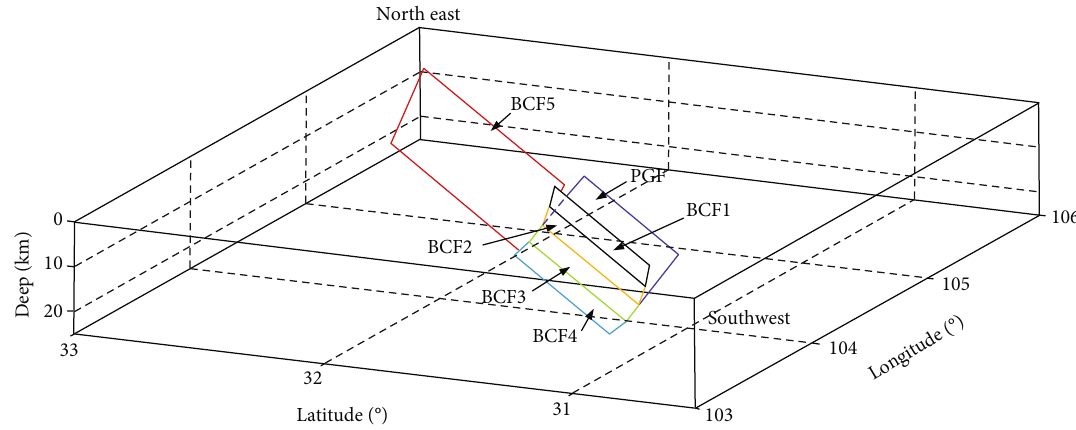
Figure 1: The 3D complex fault model of the Wenchuan